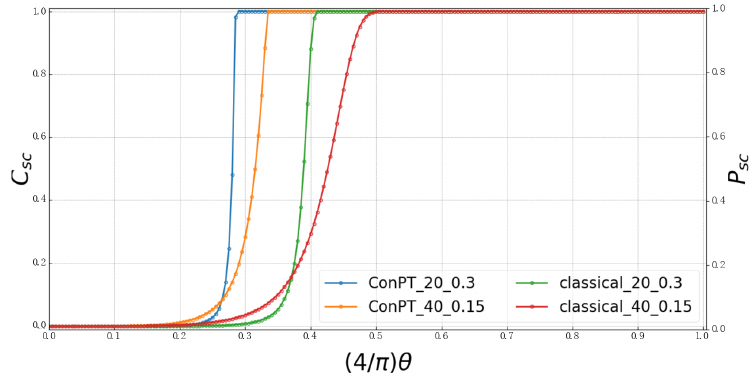
Figure 13. ConPT and classical percolation in an ER network with average degree ¯ k =